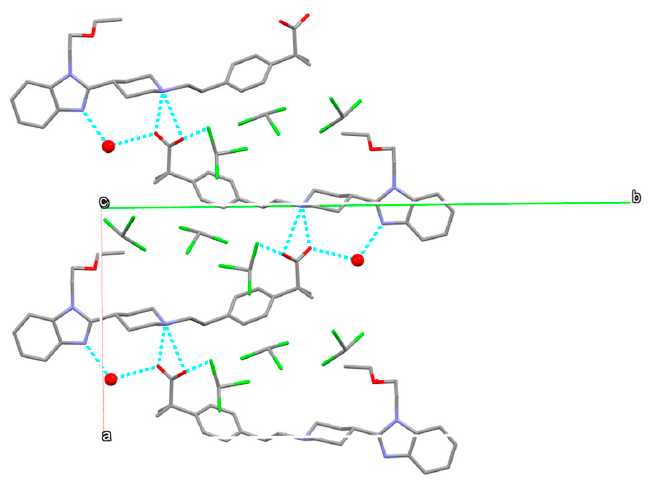
Figure 17. Carboxylate/piperidinium H-bond interactions between BL molecules observed in the crystal structure of S 3CHCl3-H2O . Water molecules represented by red balls. Hydrogens have been omitted for clarity. Water and chloroform molecules occupy voids inside the crystal structure as it is shown in Figure 18.